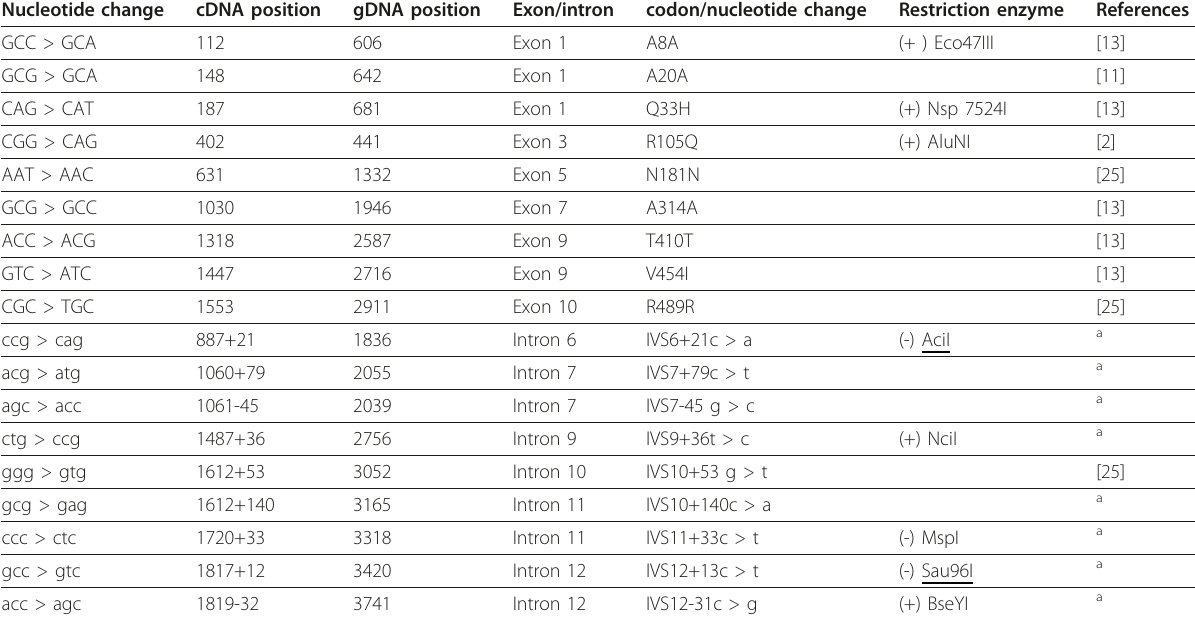
a : Novel sequence changes described in our